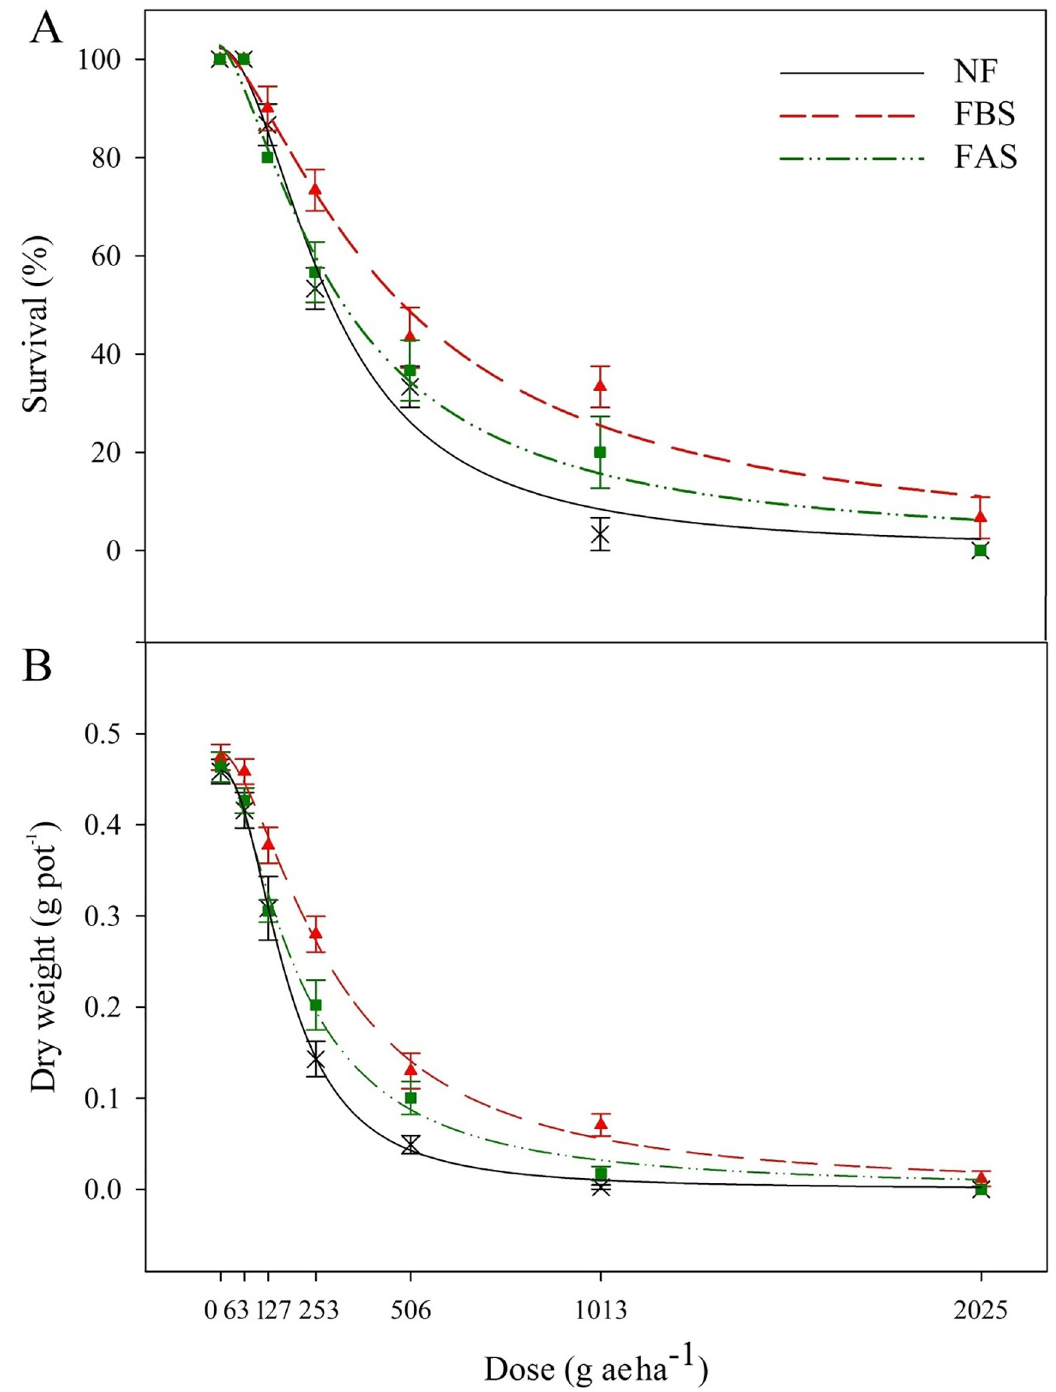
Fig 5. Survival (A) and dry weight (B) of turnipweed treated with various doses of 2,4-D plus MCPA under different freezing treatments. Abbreviation: NF (no freezing); FBS (freezing before spray): FAS (freezing after spray). The recommended dose of 2,4-D+MCPA in Iran is 1012.5 g ha -1